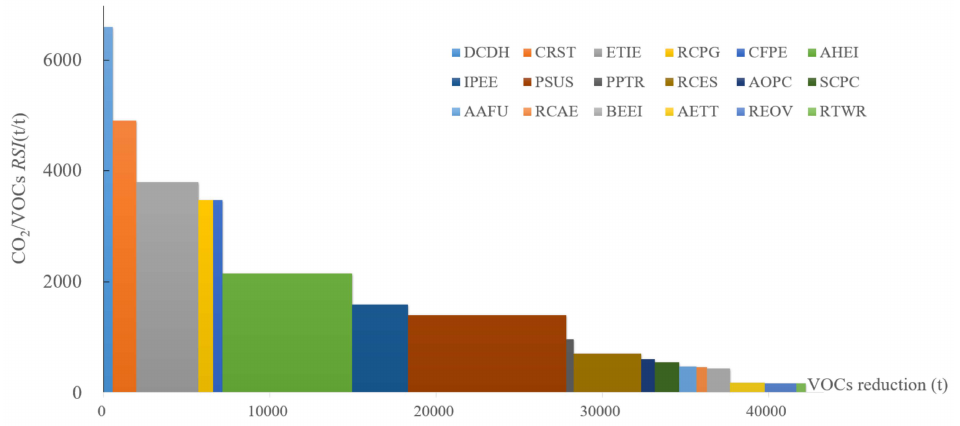
Figure 10. SRC of VOCs and CO 2 emission in 2030.